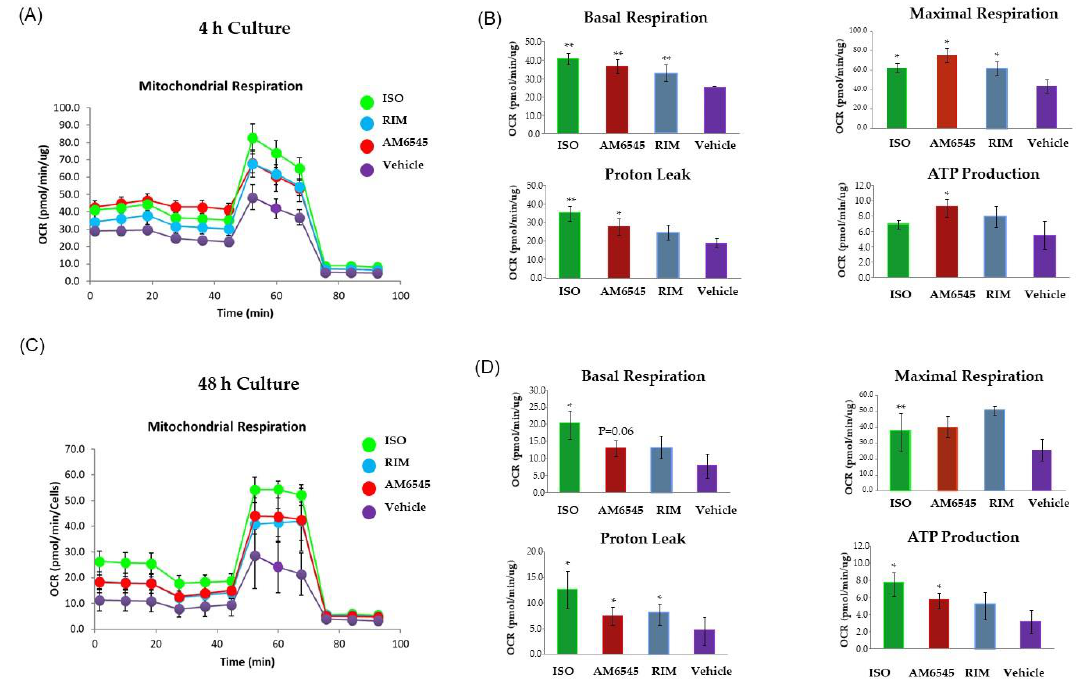
Figure 5. Peripheral cannabinoid receptor 1 (CB1R) antagonist increased oxygen consumption rate (OCR). 3T3-L1 adipocytes were treated with AM6545, rimonabant (RIM), and isoproterenol (ISO) at 4 and 48 h. OCR was measured in basal conditions or in response to sequential treatment with 2 oligomycin, 0.75 FFCP (respiratory chain uncoupler), and 1 µ M rotenone / antimycin A (inhibitor of respiratory chain complex I and complex III) using the Seahorse XF-24 analyzer. ( A ) Mitochondrial respiration curves at 4 h after treatment. ( B ) Parameters calculated from the tracing at 4 h after treatment. ( C ) Mitochondrial respiration curves 48 h after treatment. ( D ) Parameters calculated from the OCR at 48 h after treatment. Data on graphs are presented as the mean ± standard error of mean (SEM) of 4 independent rounds of the cells; * p < 0.05 vs. control, ** p < 0.01 vs.